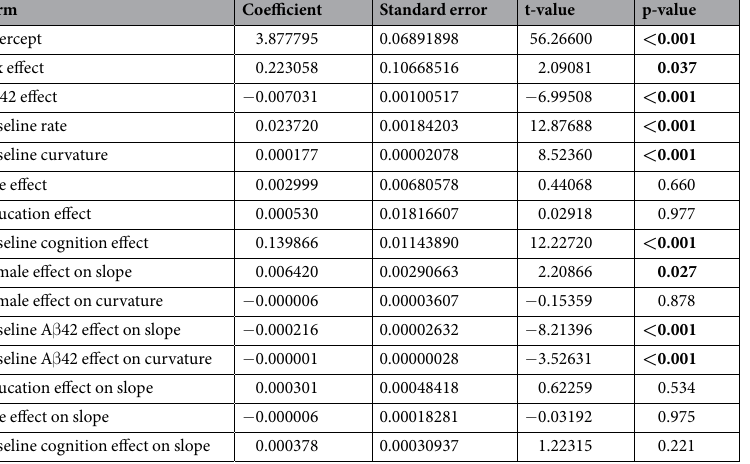
Table 3. Effect of Sex and CSF A β 42 on longitudinal change in ADAS-Cog11 of MCI subjects. Baseline cognition indicates ADAS-Cog 11. Bold p -values are statistically significant. Abbreviations: MCI (mild cognitive impairment), ADAS-Cog11 (Alzheimer’s disease assessment scale- cognitive subscale), and A β 42 (amyloid-beta 1–42 ). In this model, the follow-up time (month) was centered with the median follow-up time (36 months) and covariates were centered i.e. a 75 years old with 16 years of education, ADAS-Cog11 of 11, and A β 42 of 147. Table depicts that the effect of sex on ADAS-Cog11 slope was significant with females declining faster than males. Baseline A β 42 also had a significant effect on both slope and curvature. Age and education did not have significant effects on slope. The intercept is a term to get the correct estimate of the outcome when time = 0. The baseline rate is the reference population rate of change in the outcome starting at time zero, and the baseline curvature is the “acceleration” of that rate of change at time zero. The upper half of the table shows the effect of specific variables on ADAS-Cog11 and the bottom half shows their effects on ADAS-Cog11 slope and